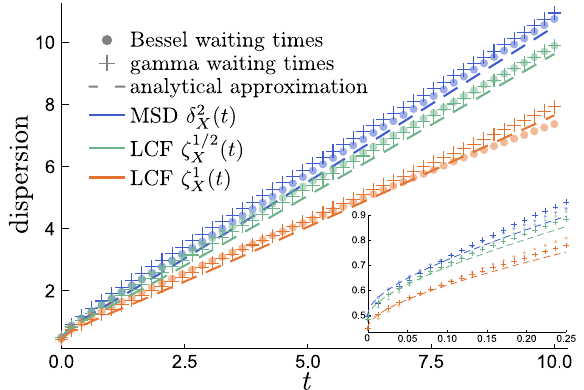
1 / 2, 1 for simulations of Bessel waiting times CTRW, Figure 8. Comparison of the MSD and LCF with ω = gamma waiting times CTRW, and their analytical approximations (22) and (23). LCF being lower than MSD shows that the distribution has more spread out bulk than